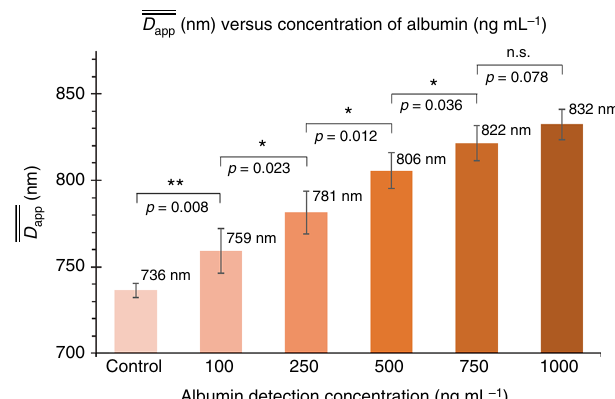
Fig. 5 The detection of albumin in the ng mL − 1 range. The bar graph represents the different D app , mean of mean D app , for various protein concentration. The control beads were not exposed to albumin, while the albumin concentrations for detection were ranged from 100 to 1000 ng mL − 1 . Four sets of experiments were independently performed and the mean of mean D app values were analysed ( n = 4) with SD as the error bars. Independent two-sample t -test is used for the statistical analysis where * p < 0.05, ** p < 0.01, and n.s. = not signi fi